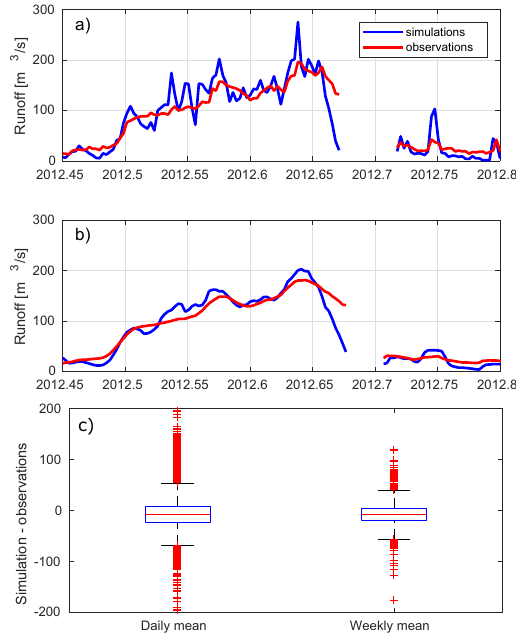
Figure 12. ( a ) Daily and ( b ) weekly mean observed and simulated runoff from Skaftá GWC; ( c ) Box plots of the prediction error for daily and weekly comparisons for the entire time